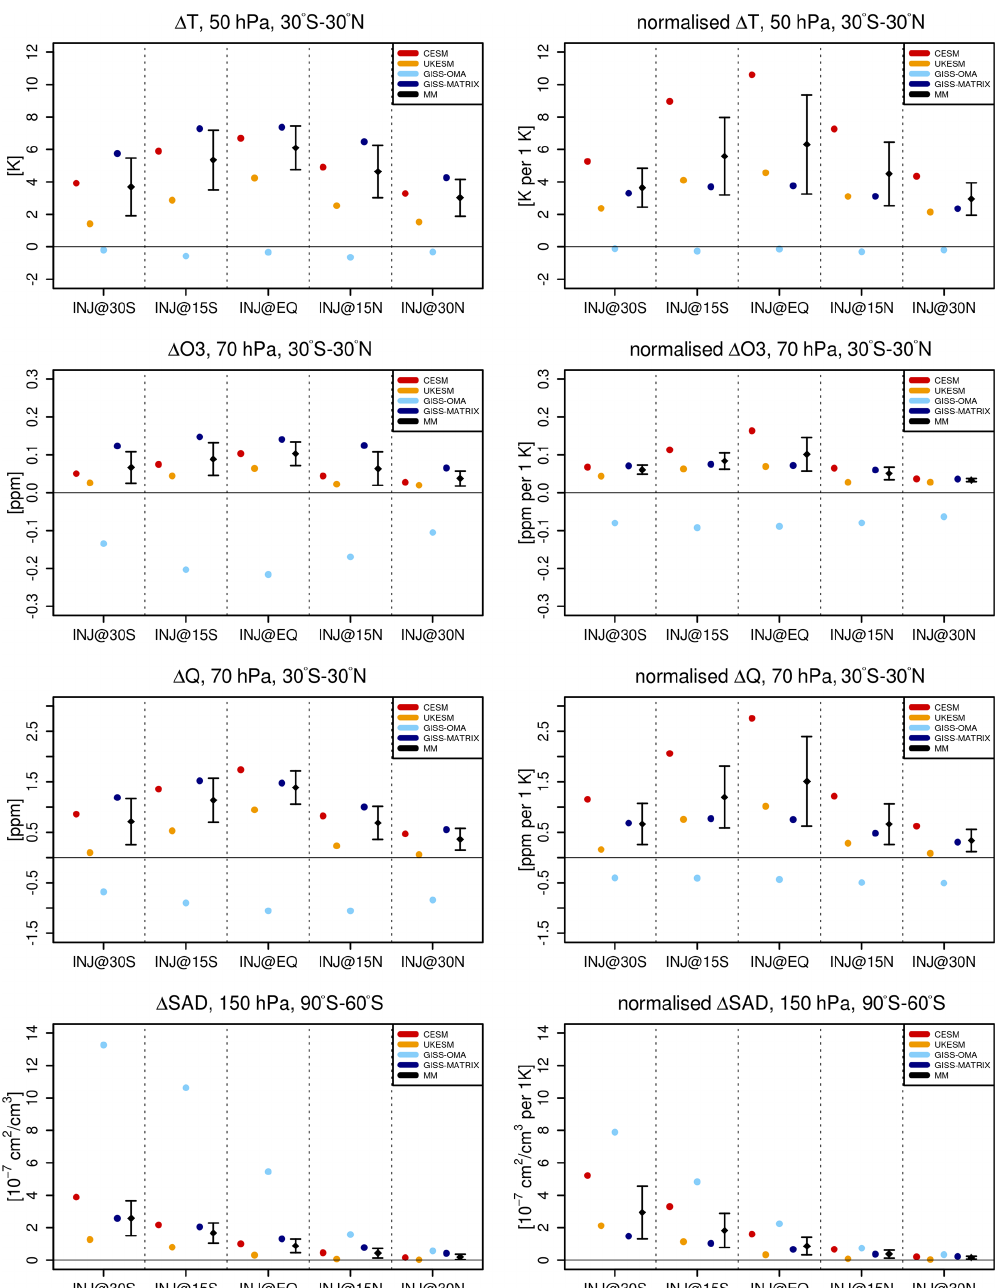
Figure 12. Yearly mean stratospheric responses simulated in each model in each simulation expressed as (left) absolute changes and (right) changes normalized with the corresponding global mean surface temperature decrease. Rows top to bottom are for changes in tropical temperature at 50hPa, tropical ozone at 70hPa, tropical water vapor at 70hPa, and Antarctic sulfate surface area densities at 150hPa. Black points and whiskers denote multi-model means of CESM2, UKESM, and GISS-MATRIX responses ± 1 standard